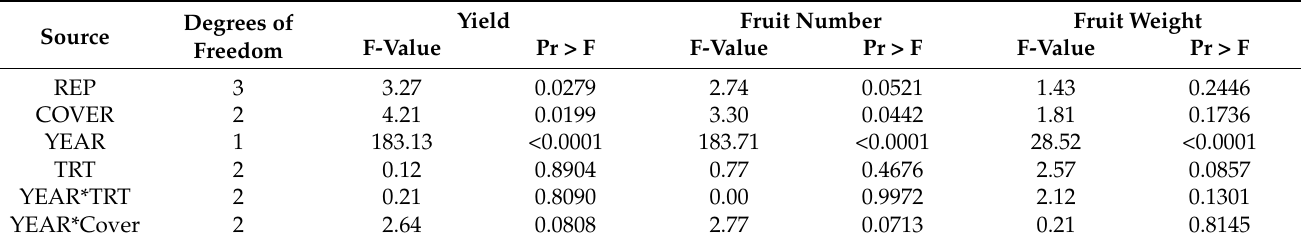
Table 13. Analysis of variance results for cantaloupe production.